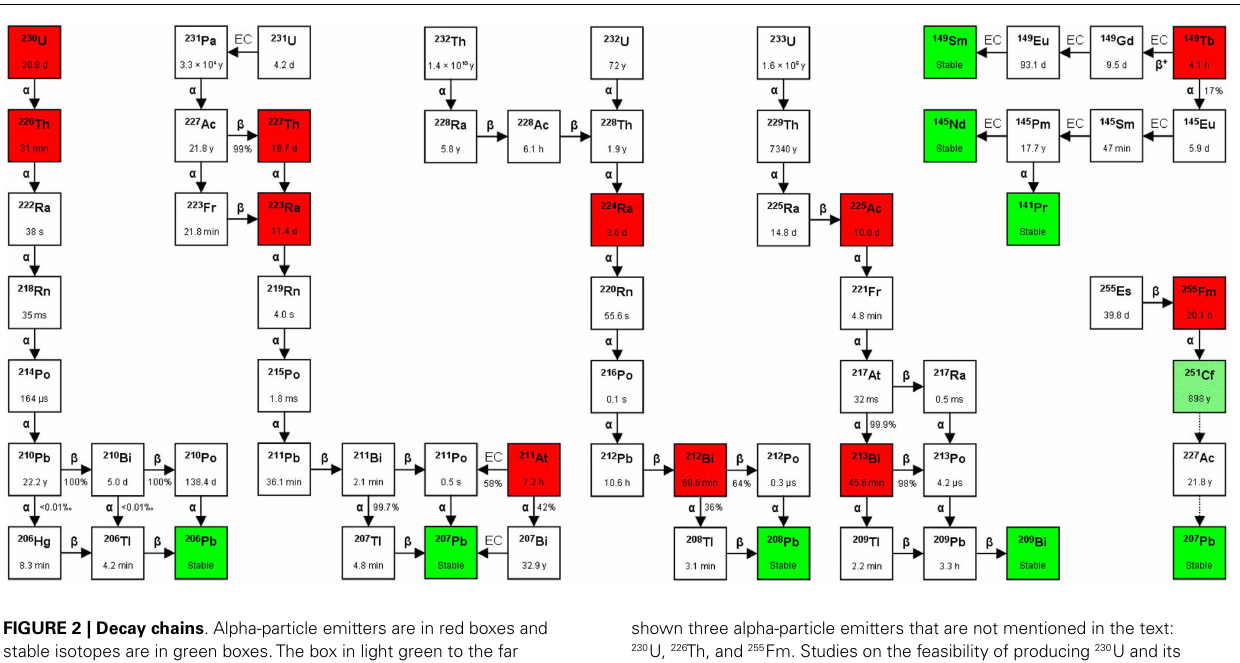
FIGURE 2 | Decay chains . Alpha-particle emitters are in red boxes and stable isotopes are in green boxes.The box in light green to the far right ( 251 Cf) indicates that although the isotope is considered stable in medical applications ( T 1/2 = 898years), it can still decay via 227 Ac to 207 Pb (stable).The T 1/2 is shown inside each box, and between boxes the type of decay [ α , β ( − / + ) , or EC (electron capture)], with the probability of each decay route occurring (expressed as %). In the figure are